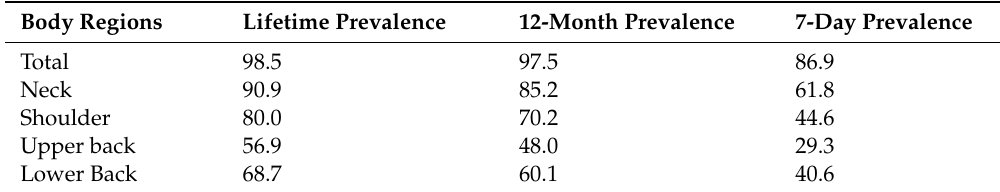
Table 6. Most frequent prevalences of MSDs among dental assistants in Germany (in %). Body